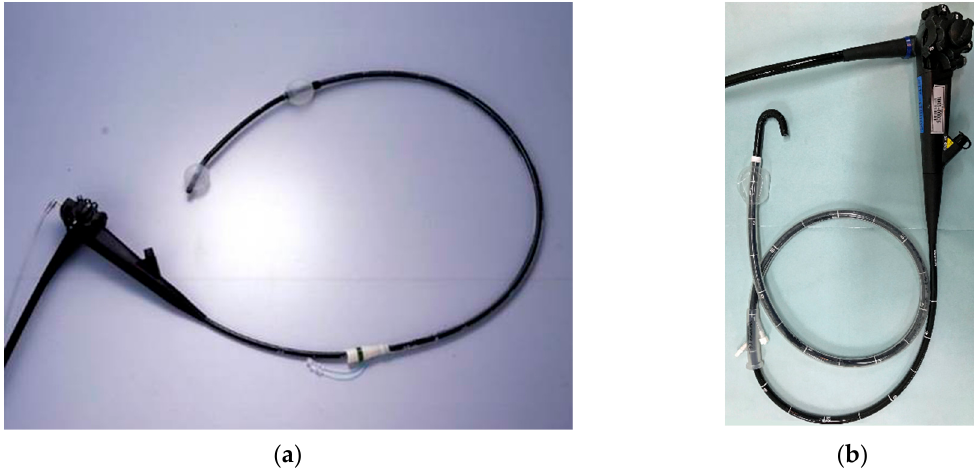
Figure 1. Balloon enteroscope: ( a ) double-balloon enteroscopy and ( b ) single-balloon enteroscopy. Use of conventional SBE and DBE is limited by their long working length of 200 cm.